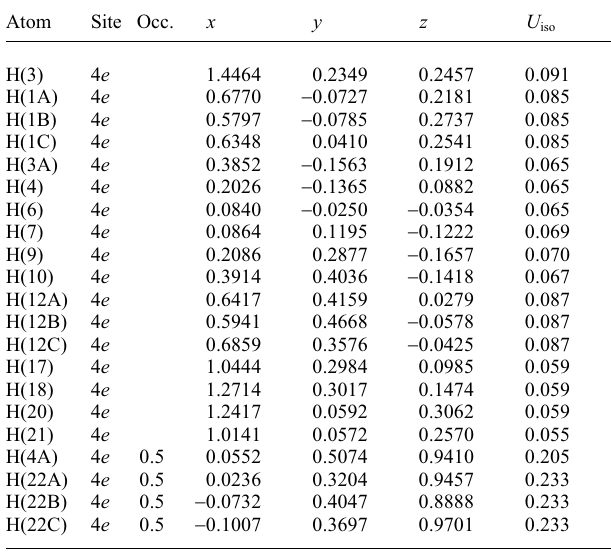
Table 2. Atomic coordinates and displacement parameters (in Å 2 )